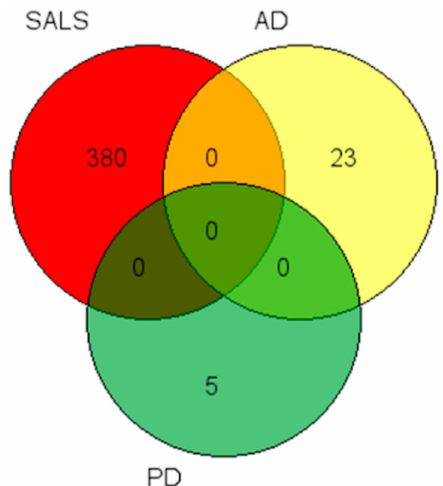
Figure 9. Venn diagram shows di ff erentially expressed genes in common among the three conditions. No common deregulated gene emerged from DE analysis. In red the number of DE genes in SALS, in yellow the number of DE genes on AD and in green the number of DE genes in